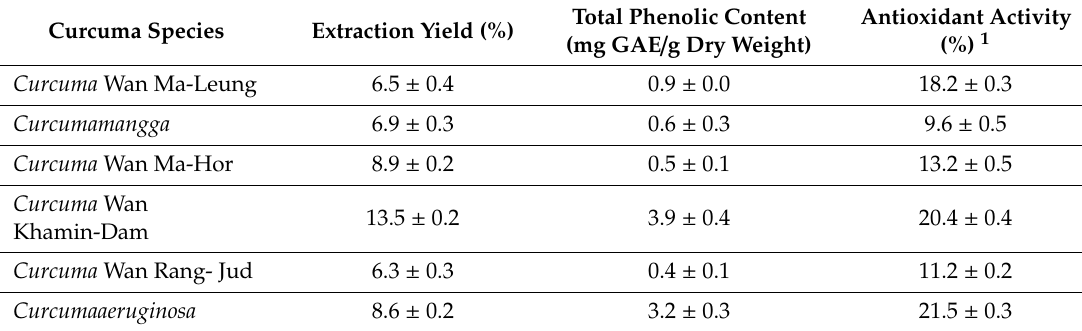
Table 2. Total phenolic content and antioxidant activity of Curcuma